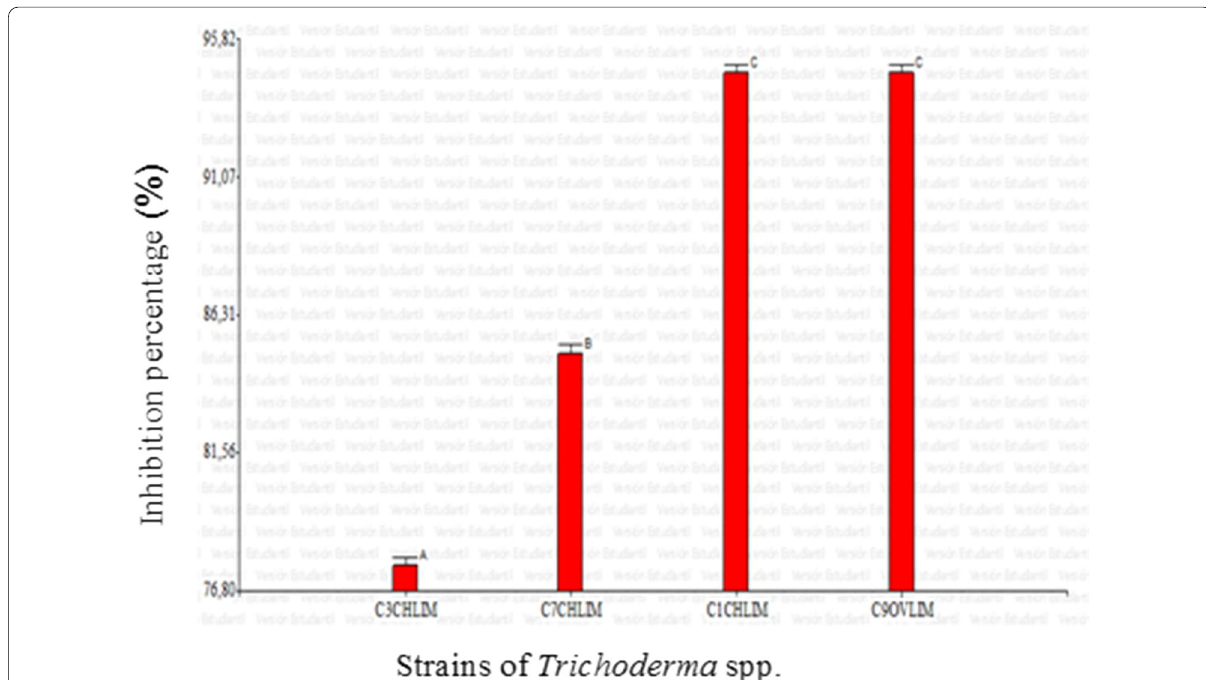
Fig. 1 Duncan rank multiple testing for the variable percentage inhibition of Trichoderma spp. strains against P. cinnamomi . Means with a common letter are nonsignificantly different ( p >